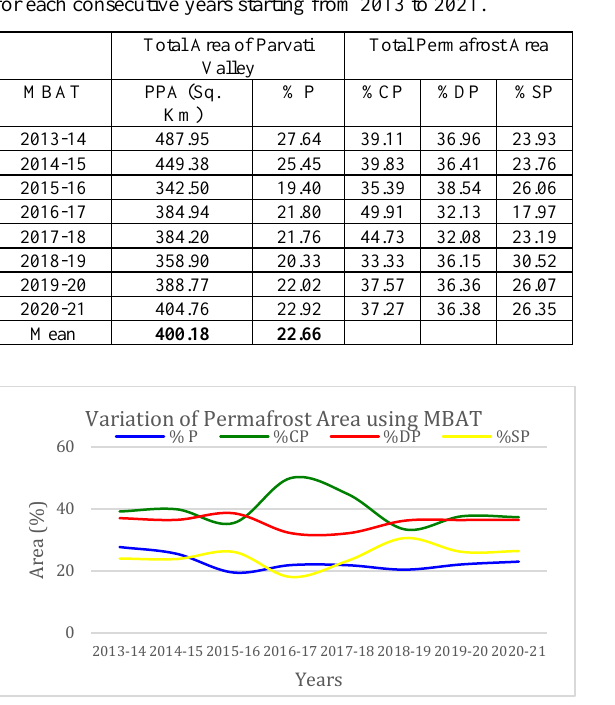
Figure 4: Graph showing variation if permafrost area when using MBAT for Parvati Valley. Area covered in each class is shown as % i.e. %P is % area covered in Permafrost, %CP is % area covered in Continuous Permafrost, %DP is % area covered in Discontinuous Permafrost, %SP is % area covered in Sporadic Permafrost